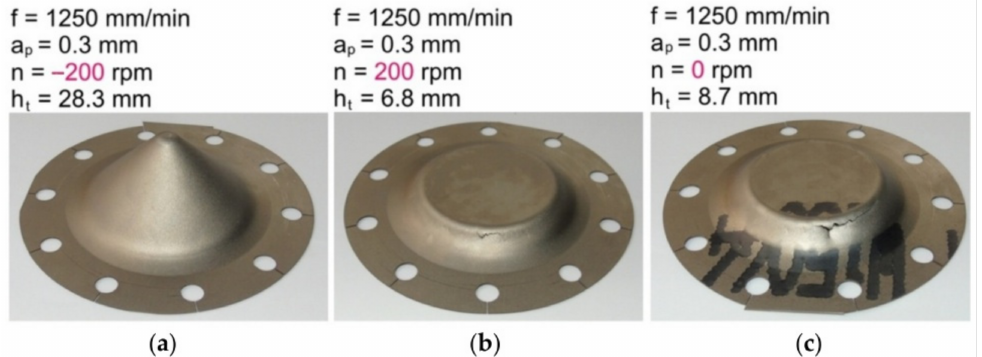
Figure 24. Grade 2 drawpieces formed at a constant step size of 0.3 mm, tool feed rate of 1250 mm/min and rotational speeds: ( a ) − 200 rpm (clockwise direction), ( b ) 200 rpm (anticlockwise direction) and ( c ) freely rotatable tool).